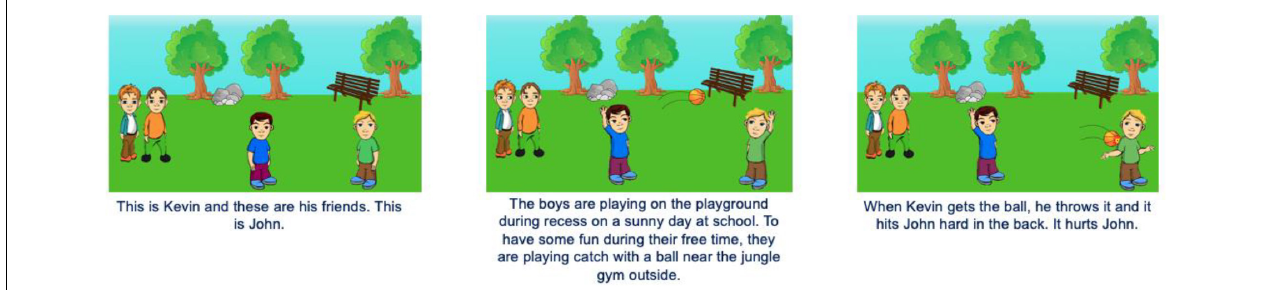
FIGURE 1 | Example story depicting physical aggression in the ambiguous condition. This story is depicted with boy characters.